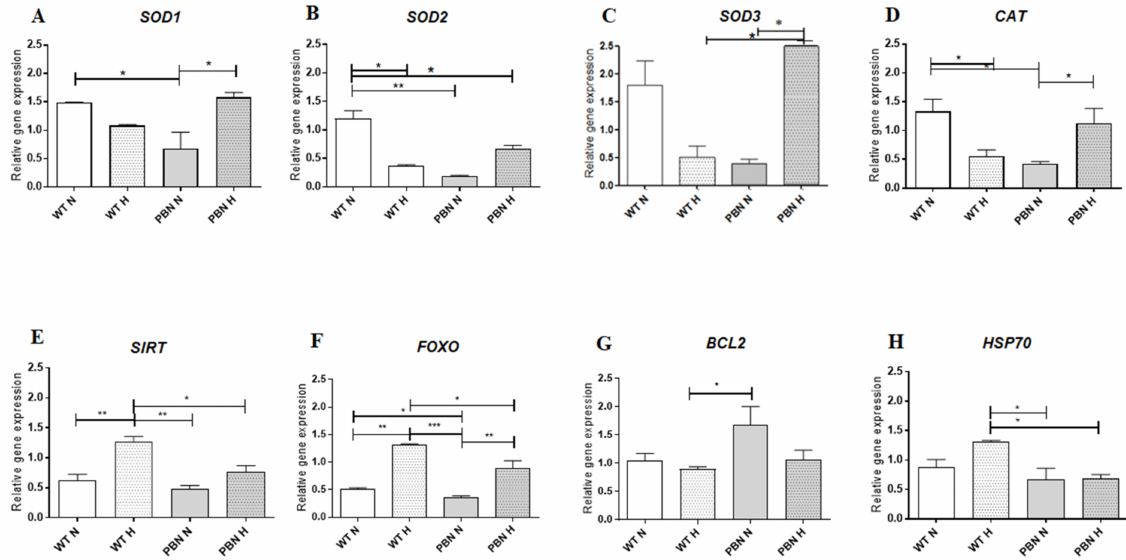
Figure 5. Expression levels of genes coding for superoxide dismutase 1 ( SOD1 ) ( A ); manganese-dependent superoxide dismutase ( SOD2 ) ( B ); extracellular superoxide dismutase ( SOD3 ) ( C ); catalase ( D ); sirtuin1 ( E ); forkhead box O3 ( F ); B-cell lymphoma 2 ( G ), and heat shock proteins ( H ) in non-treated (WT) and PBN-conditioned (PBN) SkMDS/PC populations cultured in standard (N) and hypoxic (H) in vitro conditions. Abbreviations: SkMDS/PCs = skeletal muscle derived stem/progenitor cells; WT = wild-type non-treated SkMDS/PCs; PBN = SkMDS/PCs cultured in medium conditioned with tert-butyl-alpha-phenyl nitrone. * significant at p value < 0.05, ** significant at p value < 0.01, *** significant at p value <